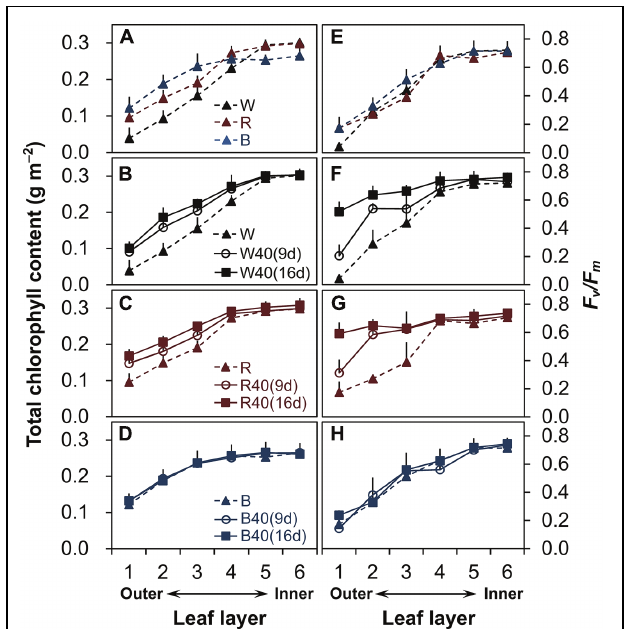
FIGURE 2 | Total chlorophyll content (A–D) and maximum quantum yield ( F v / F m ) (E–H) in lettuce leaves from the six layers of leaves in plants grown under downward lighting by white (W), red (R), or blue (B) LEDs, without or with supplemental upward lighting for 9 days (“9d”) or 16 days (“16d”) at 40 µ mol m − 2 s − 1 PPFD. Data represent means ± SD ( n = 3 to 5). (A,E) No supplemental upward lighting. (B–D,F–H) Same downward lighting as in (A) , but with supplemental (B,F) white, (C,G) red, or (D,H) blue upward lighting.